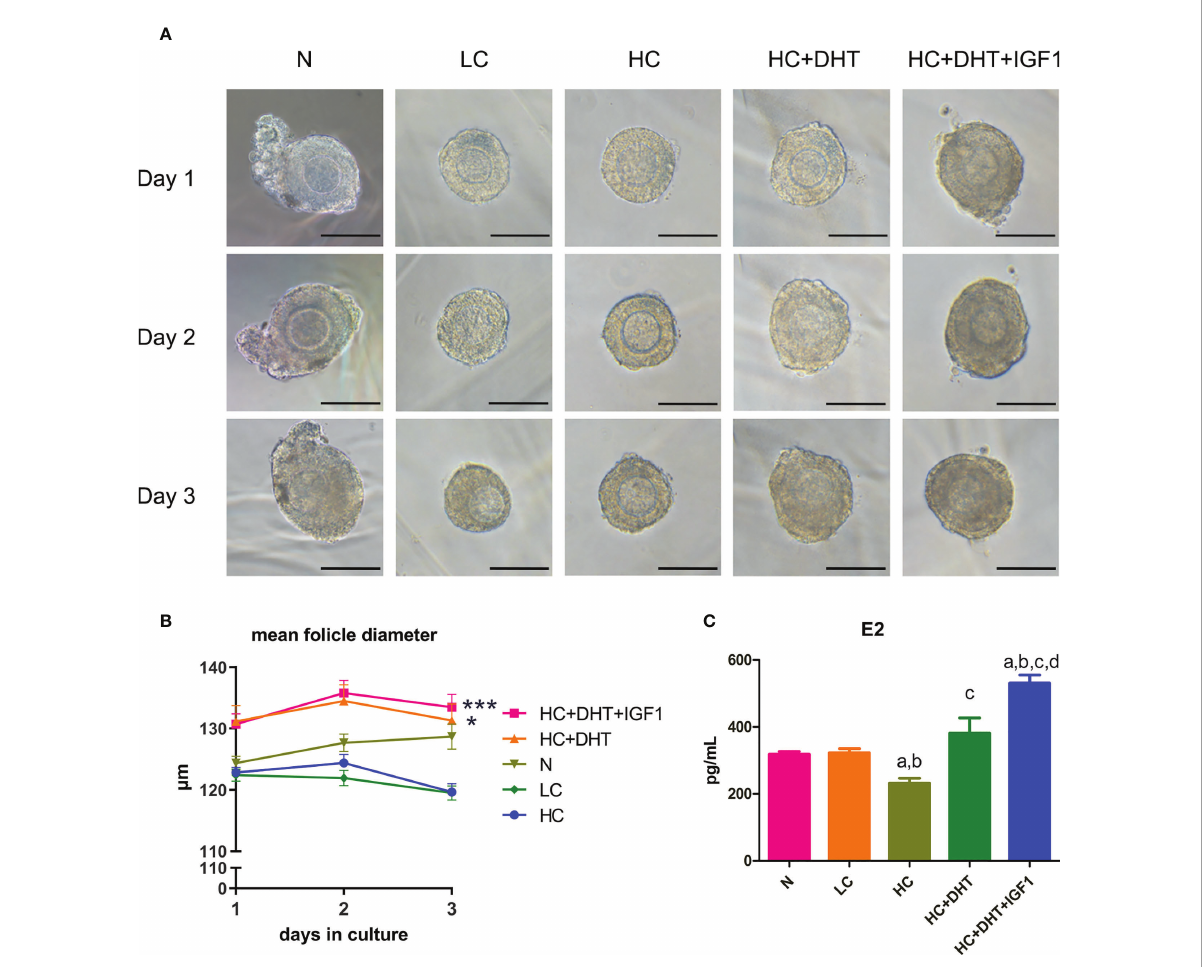
FIGURE 9 The effect of glucocorticoids on the development of 3D cultured mouse ovarian follicles and the therapeutic effect of androgens. Mouse ovarian follicles were isolated and 3D-cultured in alginate beads for 3 days. The follicles were divided into normal (N), 0.1 µM CORTN (LC), 1 µM CORTN (HC), HC + 10 nM DHT (HC+DHT), and HC + 10 nM DHT + 100 ng/ml IGF1 (HC+DHT+IGF1) groups. The culture medium was supplied with and without listed drugs, respectively. The morphology (A) and average diameter (B) of follicles in each group were monitored for 3 days. n ≥ 30 in each group; repeated-measures ANOVA. After 3 days of culture, culture medium supernatant was collected for ELISA assay to determine the E2 concentration. n ≥ 7 in each group; one-way ANOVA. (C) *P < 0.05 compared to group “ N ” ; ***P < 0.001 compared to group “ N ” ; a: P < 0.05 compared to group “ N ” ; b: P < 0.05 compared to group “ LC ” ; c: P < 0.05 compared to group “ HC ” ; d: P < 0.05 compared to group “ HC+DHT. ”